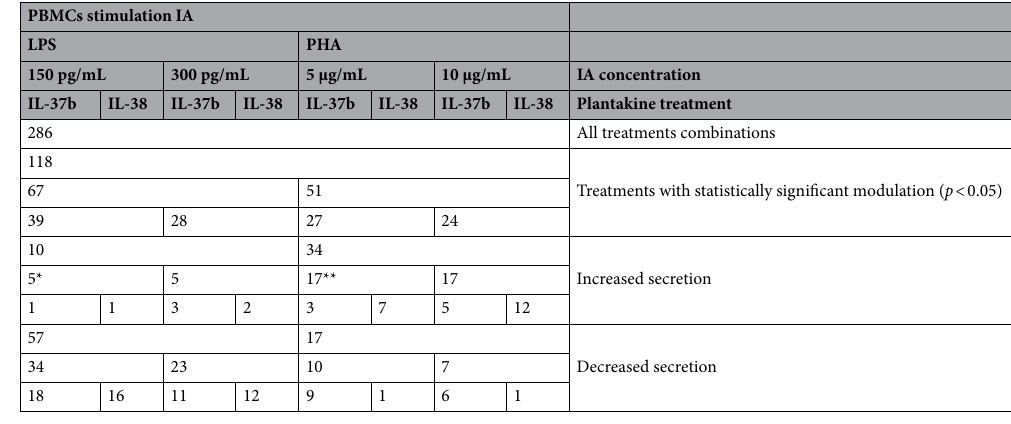
Table 1. Modulation in levels of inflammatory cytokines secreted from IA-stimulated PBMCs with applied IL-37b and IL-38 plantakines treatments. *—includes 3 treatments combinations with simultaneous application of both plantakines. **—includes 7 treatments combinations with simultaneous application of both